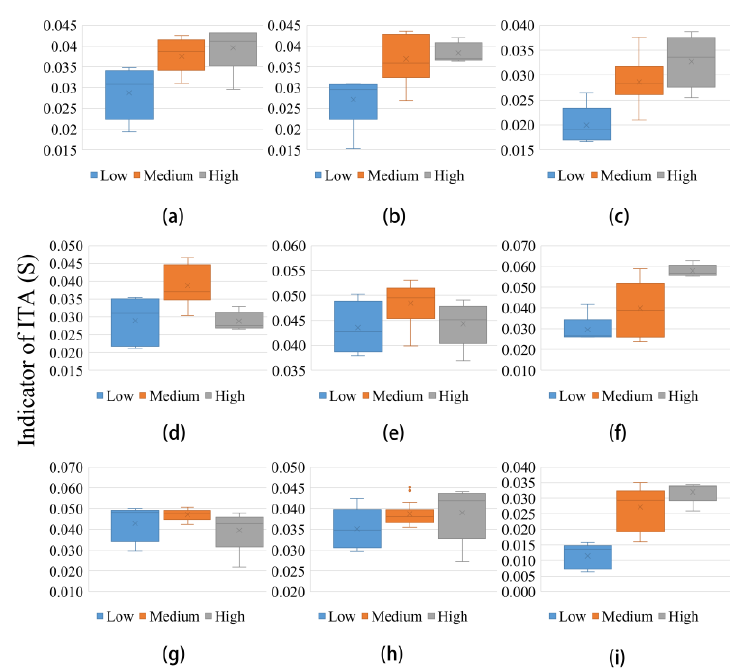
Figure 7. Median value of S (indicator of ITA) for the minimum temperature over the whole JRB: ( a ) annual, ( b ) spring, ( c ) summer, ( d ) autumn, ( e ) winter. Annual minimum temperature in the sub-basins ( f ) SRJRB, ( g ) UPJRB, ( h ) YLRB, and ( i ) MLJRB. Blue, orange, and gray box denote the low, medium, and high categories, respectively.